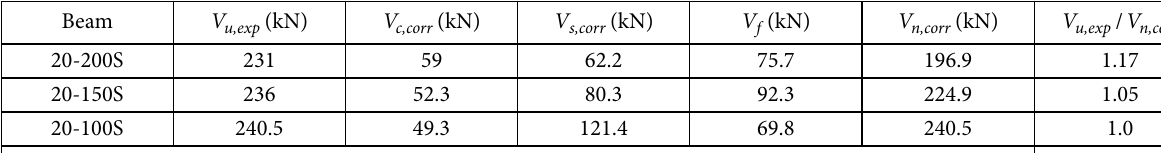
Table 3. Comparison of shear capacity between analytical and experimental results